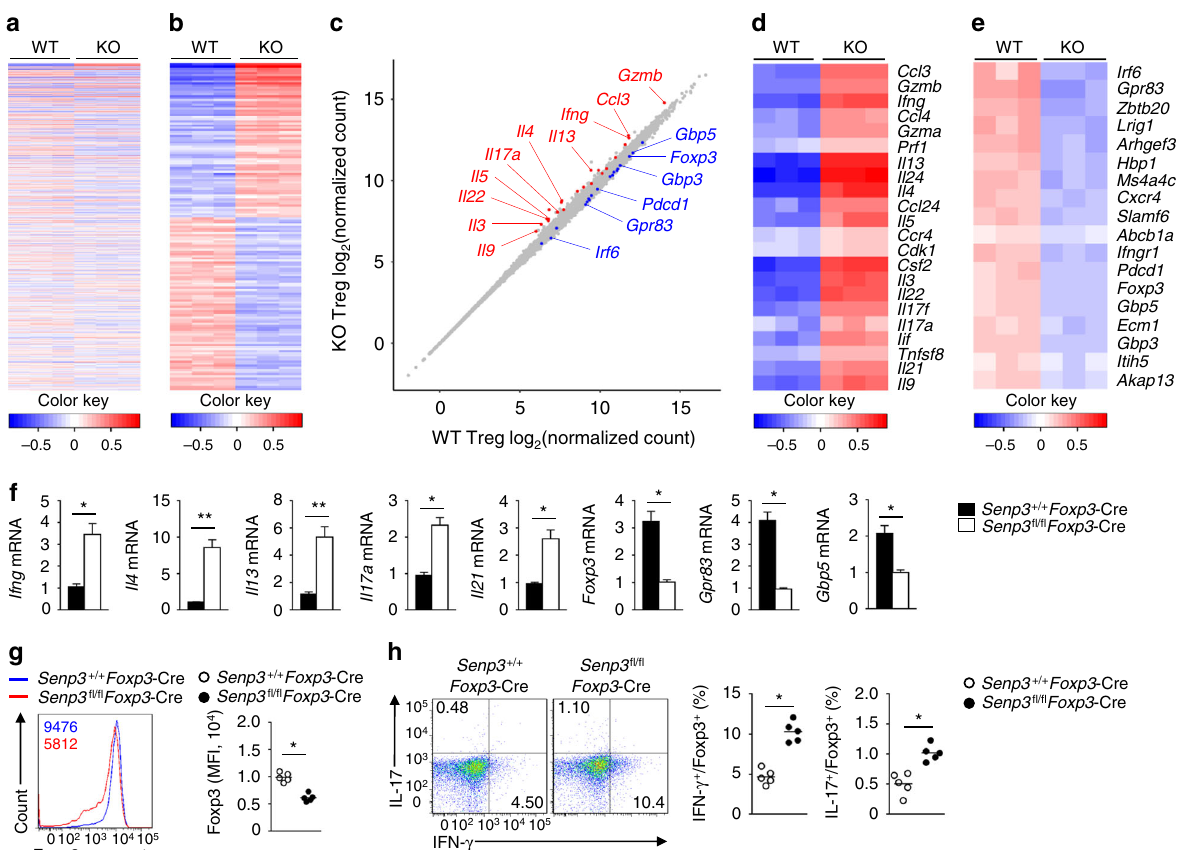
Fig. 4 SENP3 regulates Treg cell effector programs and stability. a – e Splenic Treg cells (CD4 + CD25 + YFP + ) obtained from 6-week-old female Senp3 + / + Foxp3 -Cre (WT) mice and Senp3 fl / fl Foxp3 -Cre (KO) were stimulated with anti-CD3 and anti-CD28 antibodies for 24h and subjected to RNA sequencing. A heat map of highly variable genes (top 1000) ( a ) and a heat map of genes with a fold change >2 and adjusted P value < 0.01 ( b ) were shown. Scatter plot showing gene expression in the KO versus WT Treg cells ( c ). Teff cell-speci fi c genes are highlighted in blue, and the Treg cell-speci fi c genes are highlighted in red. Clustering of upregulated Teff cell-speci fi c genes identi fi ed in SENP3-de fi cient Treg cells relative to that in Senp3 -WT Treg cells ( d ). Treg cell-speci fi c gene expression in SENP3-de fi cient Treg cells and Senp3 -WT Treg cells ( e ). f qRT-PCR analysis of the indicated genes in anti- CD3 and anti-CD28 antibody-stimulated Treg cells from Senp3 + / + Foxp3 -Cre and Senp3 fl / fl Foxp3 -Cre mice. g , h Flow cytometric analysis of Foxp3 expression ( g , the numbers above the graphs indicate MFI of Foxp3) or IFN- γ and IL-17 expression ( h ) in Senp3 + / + Foxp3 -Cre and Senp3 fl / fl Foxp3 -Cre Treg cells (CD4 + CD25 + YFP + ) stimulated with anti-CD3 and anti-CD28 antibodies for 24 h. Data are presented as representative plots (left) and summary graphs of percentage and MFI of Foxp3 (right). Data in f , g , h are representative of three independent experiments and are presented as the means ± SEM. n = 5. Two-tailed unpaired Student ’ s t tests were performed. * P < 0.05; ** P <